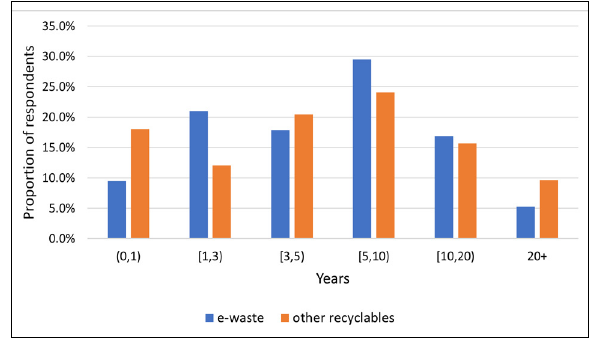
Years collecting e-waste and other